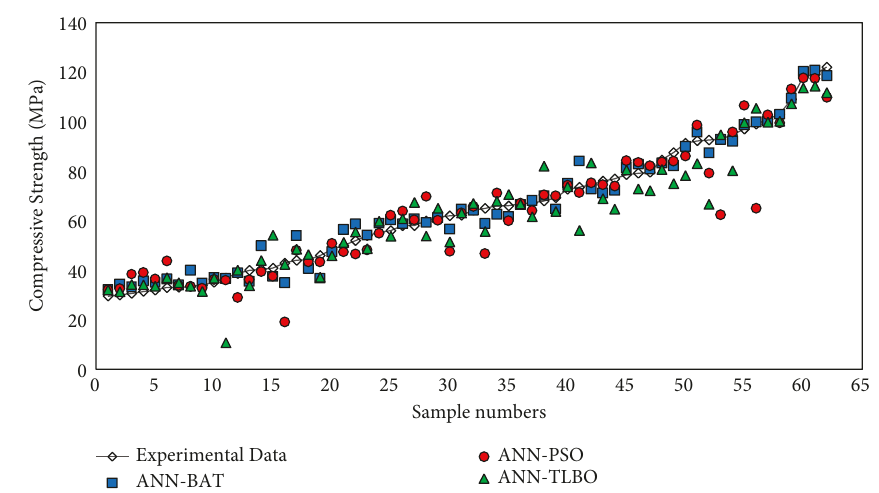
Figure 10: Prediction comparison of all models by using testing data.